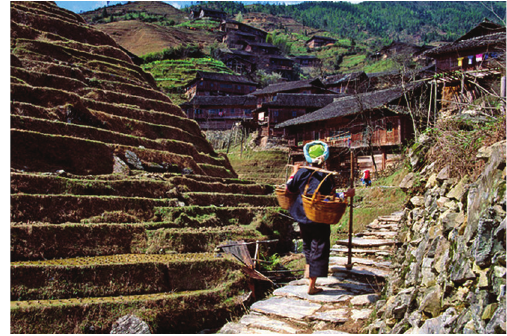
Figure 2: A village in Guangxi county, China (Permission, China- Span.com).